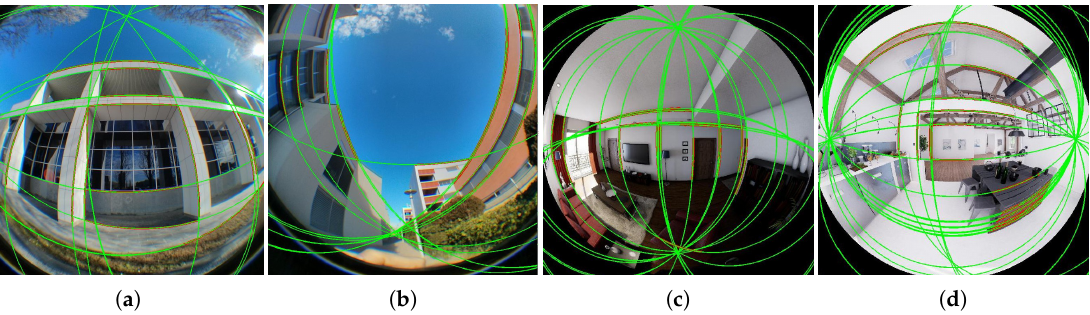
Figure 9. Line extraction on fish-eye camera. ( a , b ): Real fisheye images from examples of [34]; ( c , d ): Synthetic images from our simulator.